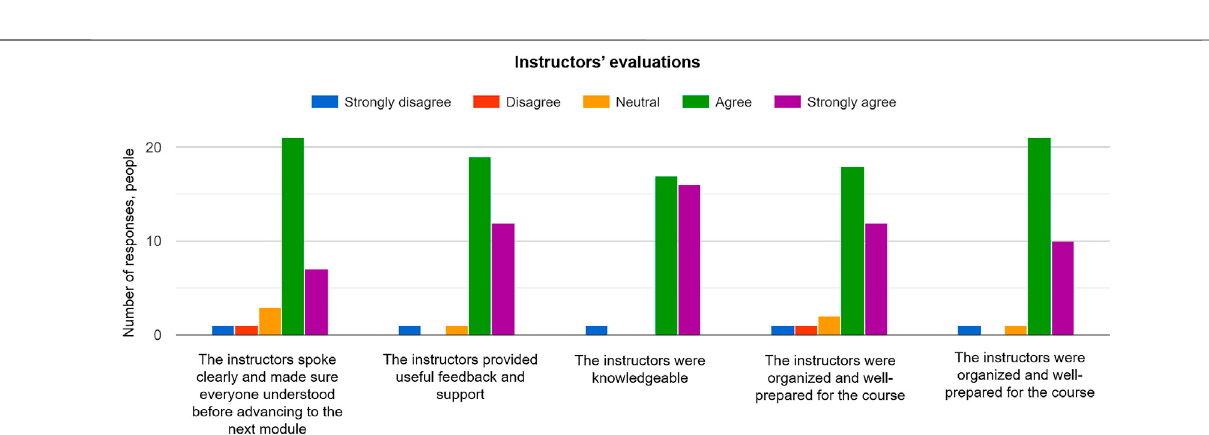
FIGURE 8 | Responses of participants for evaluation of the time spent on each module of the short course.